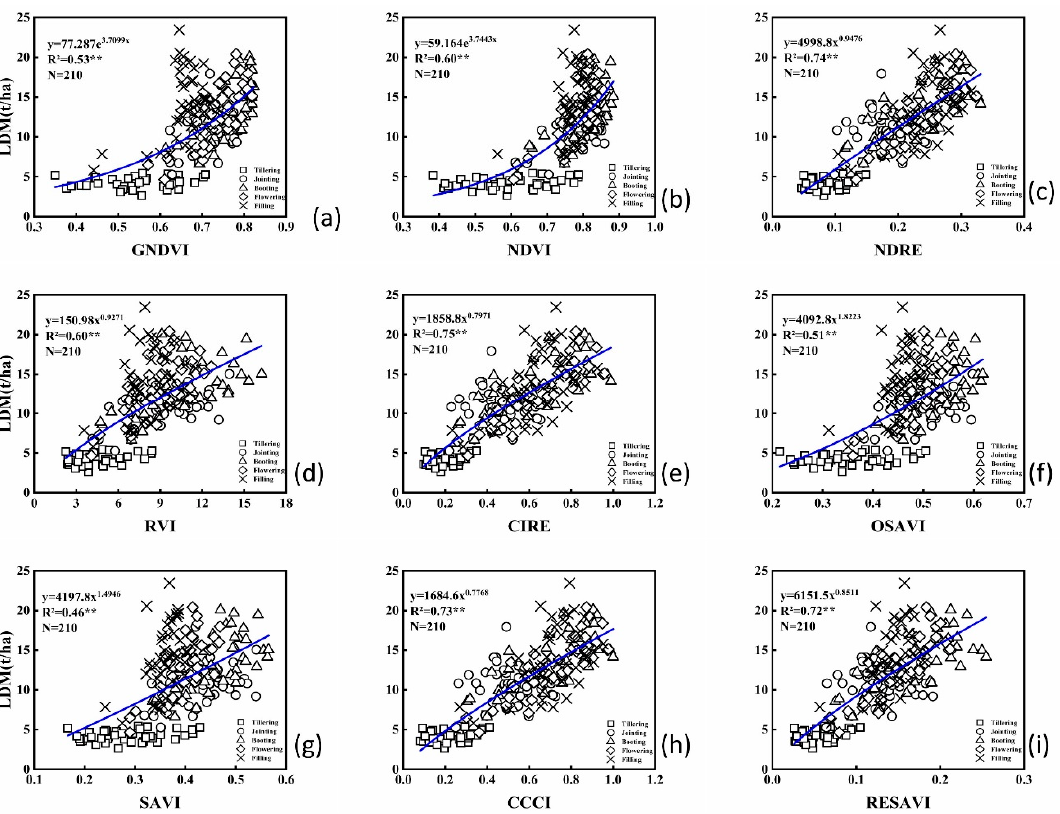
Figure 6. Leaf dry matter (t ha − 1 ) plotted against vegetation indices for the whole season: ( a ) GNDVI; ( b ) NDVI; ( c ) NDRE; ( d ) RVI; ( e ) CIRE; ( f ) OSAVI; ( g ) SAVI; ( h ) CCCI; ( i ) RESAVI.